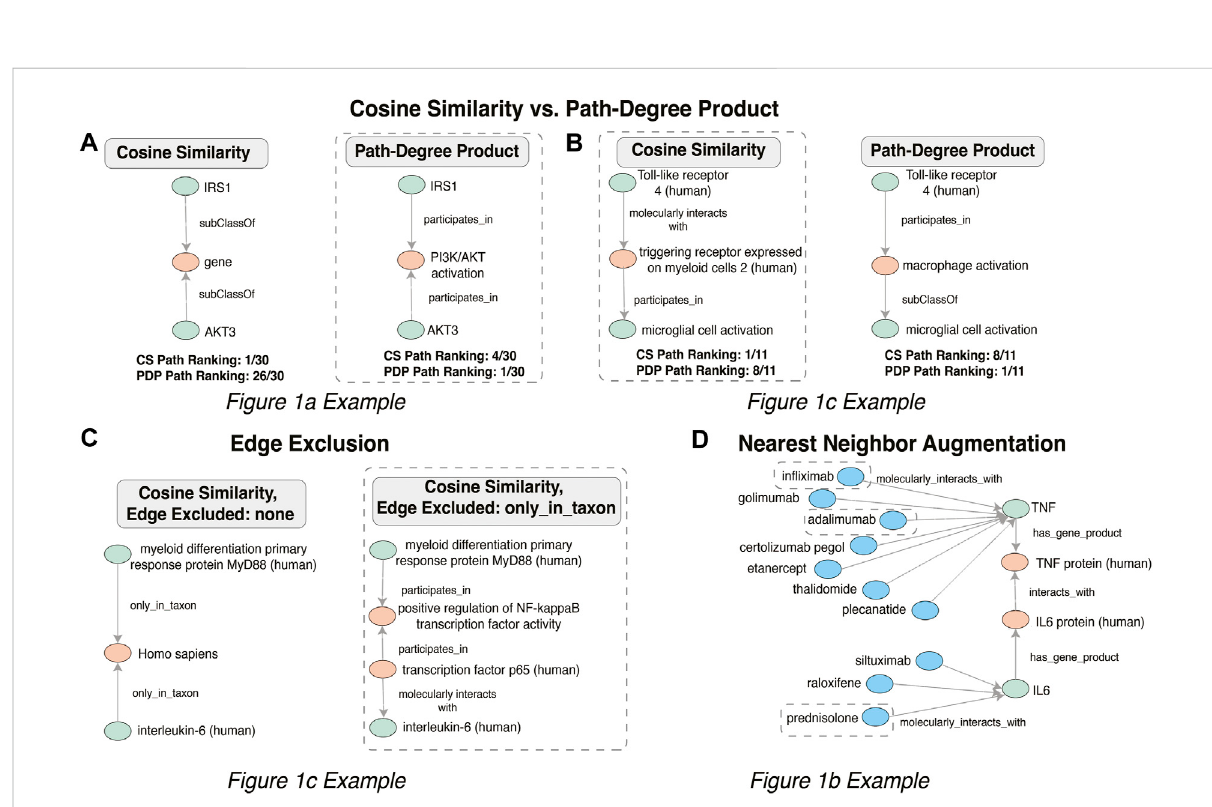
FIGURE 5 Changes in intermediate nodes between given source and target concepts when the Cosine Similarity (A) and Path-Degree Product path ranking algorithm (B) were applied, when Edge Exclusion (C) was applied and when nearest neighbor augmentation (D) of drugs was applied, with those relationships that aligned with the original example Figure 1B